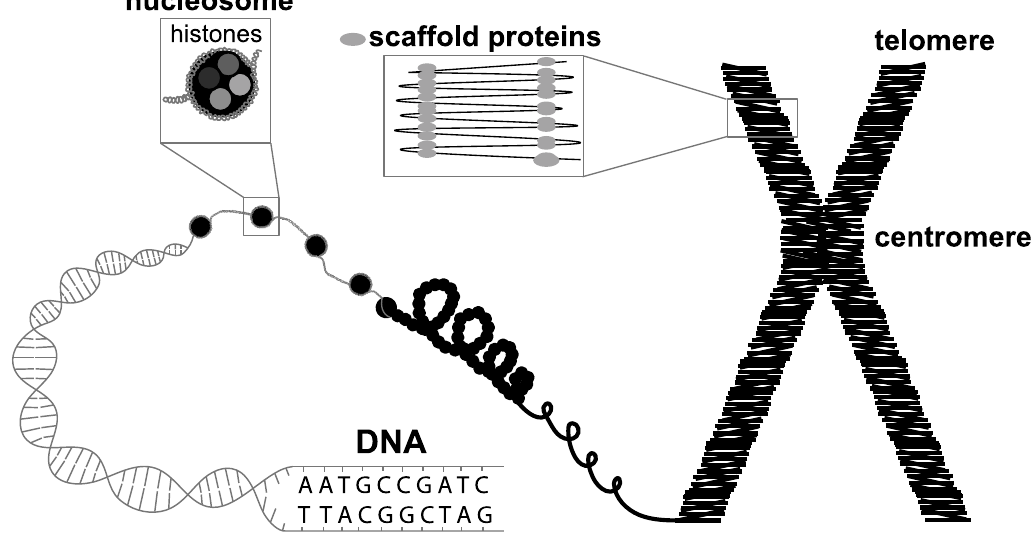
Figure 1. Repacking the DNA into a chromosome. The double-stranded DNA helix is wrapped around a nucleosome consisting of eight histone proteins to produce a chromatin fibre, which is attached to a backbone of non-histone proteins called scaffold proteins which form the chromosome scaffold.